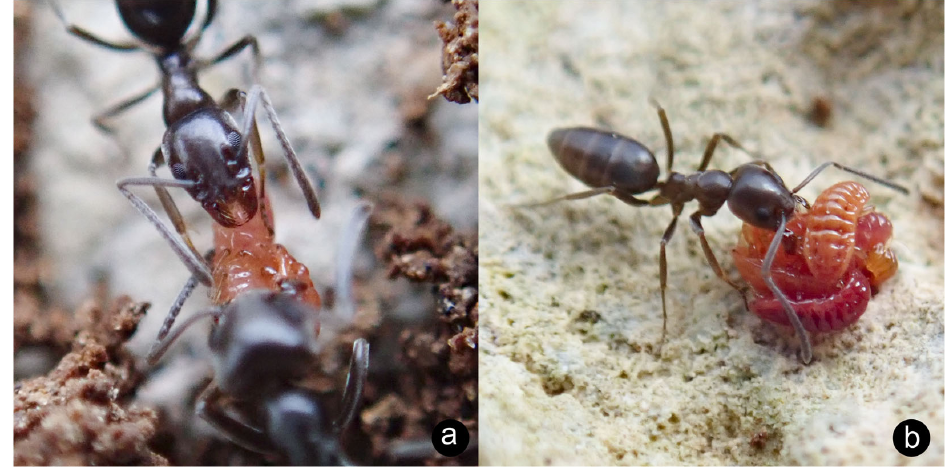
Figure 3. Lacombia dactyloni individuals carried by Tapinoma after lifting rock off nest, Dingli; ( a ) individuals being transferred from one worker to another; ( b ) individuals carried as a spherical mass by a